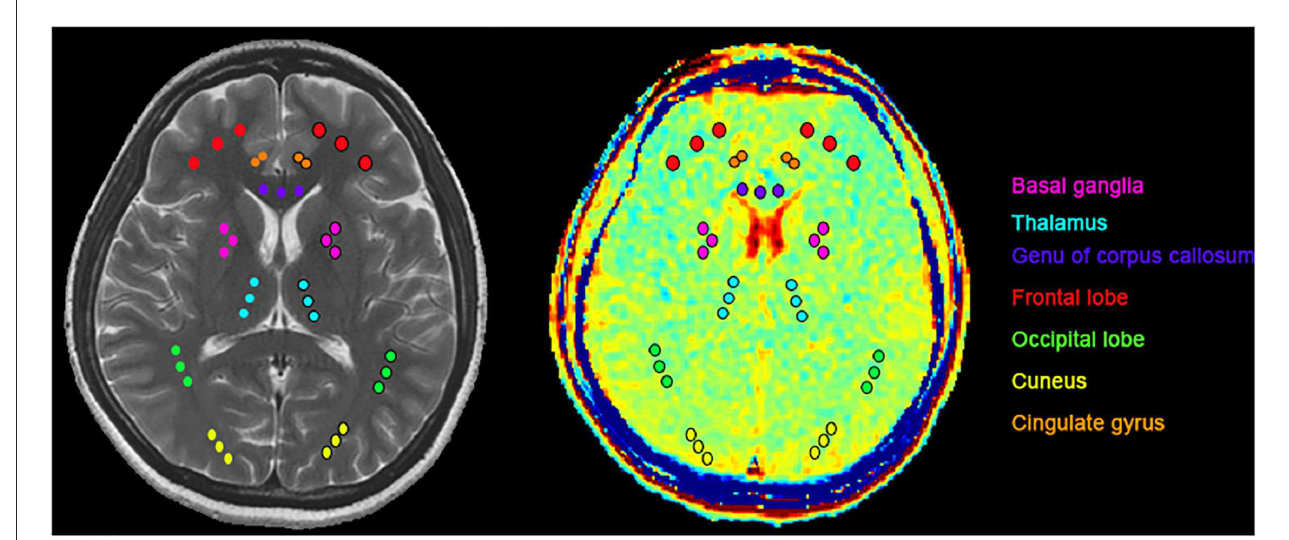
FIGURE1 ROIs for T2WI and GluCEST: basal ganglia (pink), thalamus (light blue), the genu of the corpus callosum (purple), frontal lobe (red), occipital lobe (green), cuneus (yellow), cingulate gyrus (orange). Except for the basal ganglia region and the thalamus, the ROI was placed in the gray matter region, and for other brain regions, the ROI was placed in the white matter